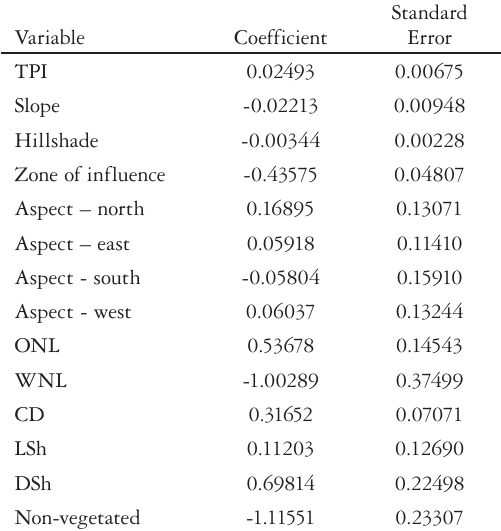
Table 5. Variables included in the most parsimonious model of adult female caribou winter habitat selection in the Southern Lakes region of the Yukon Territory,